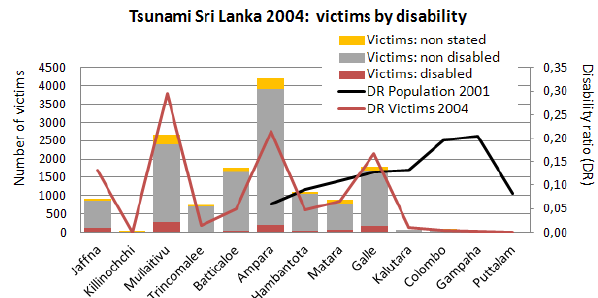
Figure 9. Tsunami victims in Sri Lanka (2004) by disability and pre-/post-tsunami disability ratios (disability ratio = disabled by district/total disabled). No data about disabled population in the Tamil districts (Jaffna–Batticaloe) are available in the 2001